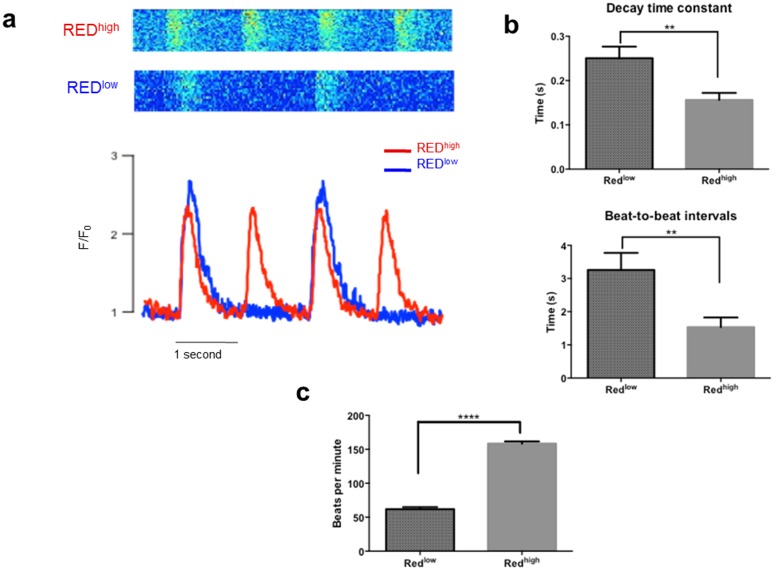
Redhigh cells possess functional Ca2+ handling properties similar to atrial cardiomyocytes.(a) Representative spontaneous calcium transients recorded from redhigh and redlow cells. (b) Quantification of calcium transient decay and interval properties in redhigh (n = 13) and redlow (n = 13) cells (**p<0.01). (c) Quantification of beating rate in spontaneously beating redhigh (n = 22) and redlow (n = 23) cells (****p<0.0001).